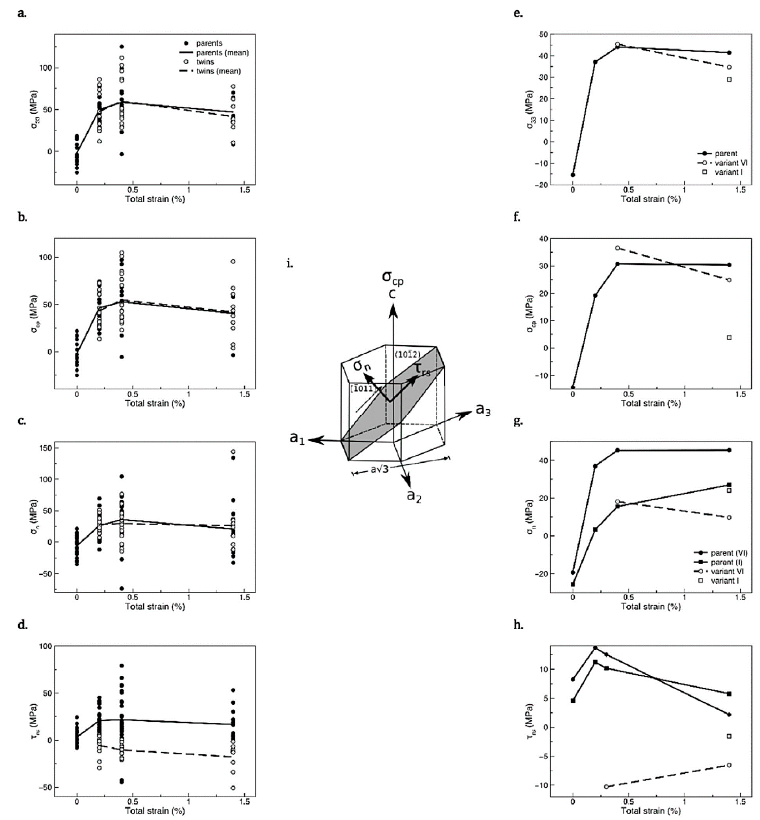
Figure 29. Stress evolution inside the untwinned parent and twinned children grains: The results for 15 parent grains and 20 twinned children nucleated within those parent grains ( a ) σ 33 , ( b ) σ cp , ( c ) σ n , ( d ) τ rs . The results for a single untwinned parent grain and two twin variants nucleated from that grain ( e ) σ 33 , ( f ) σ cp , ( g ) σ n , ( h ) τ rs . ( i ) The schematics of the stress components presented in ( a – h ) (After Abdolvand et al. [27]).